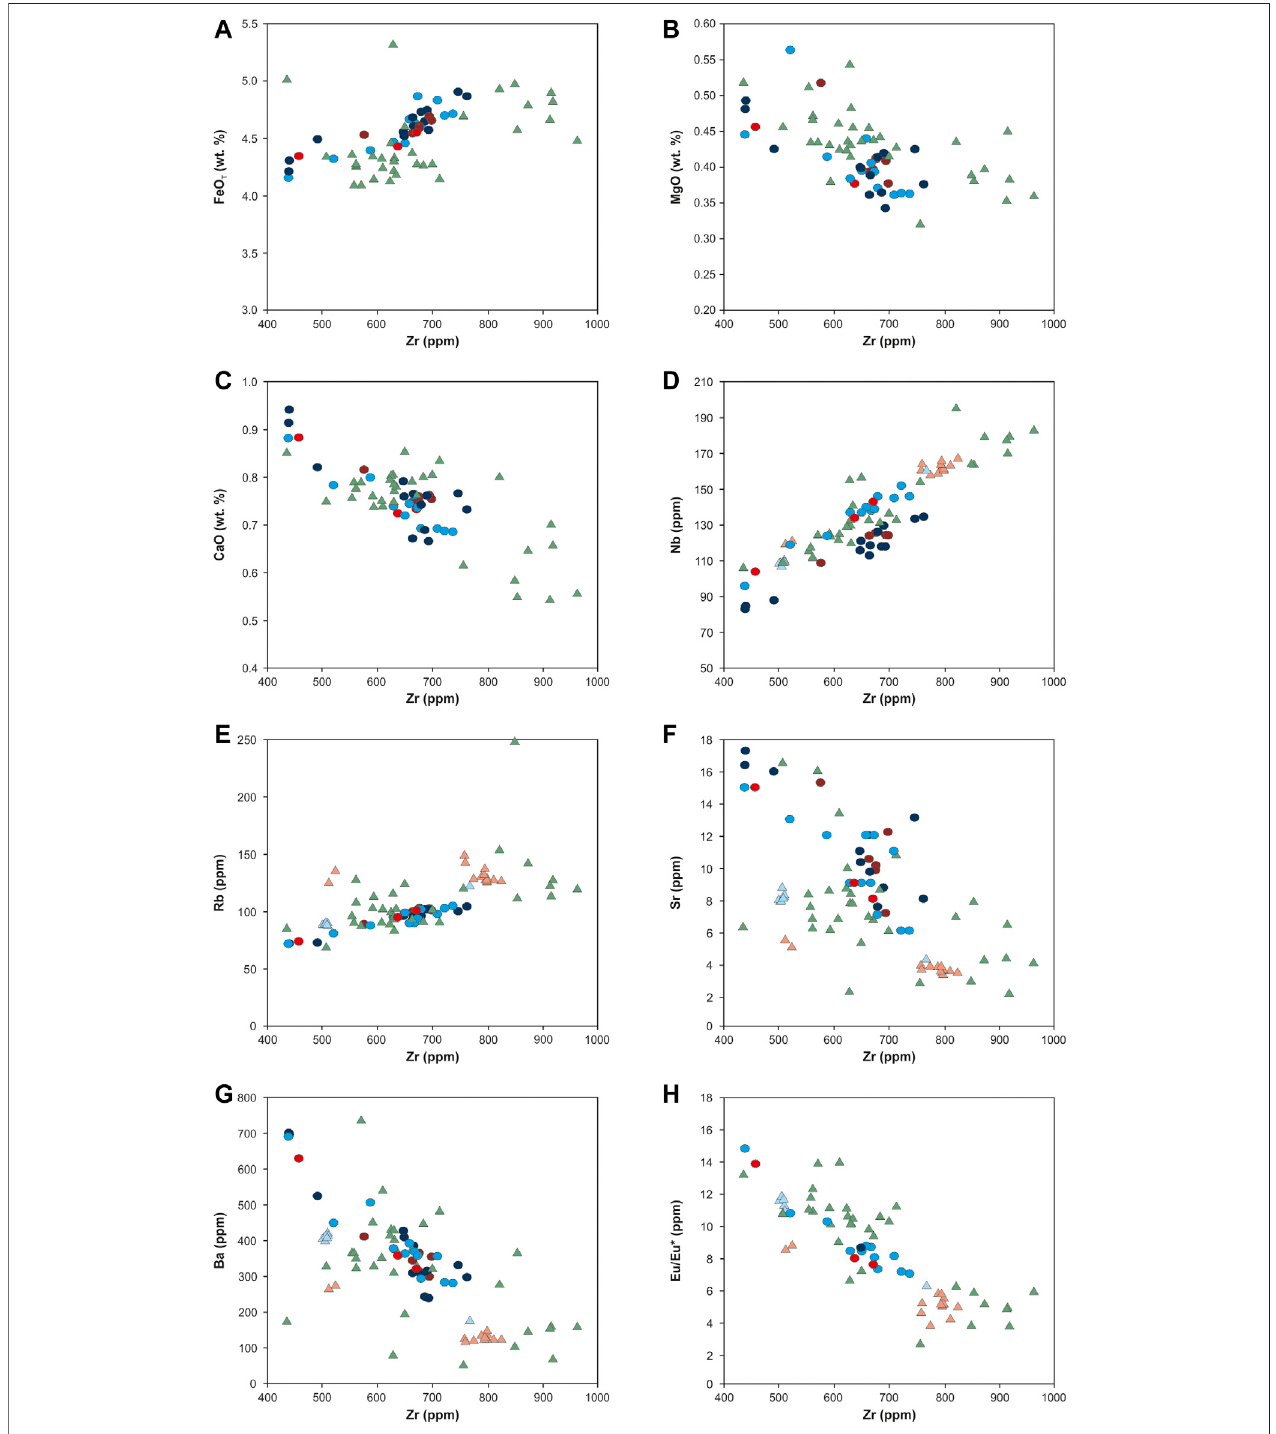
FIGURE 13 | Selected major and trace element data plotted vs. Zr, which is applied as an index of differentiation. Major element data are reported in wt. %, trace elements as ppm. All symbols and data sources are as given in Figure 12 .